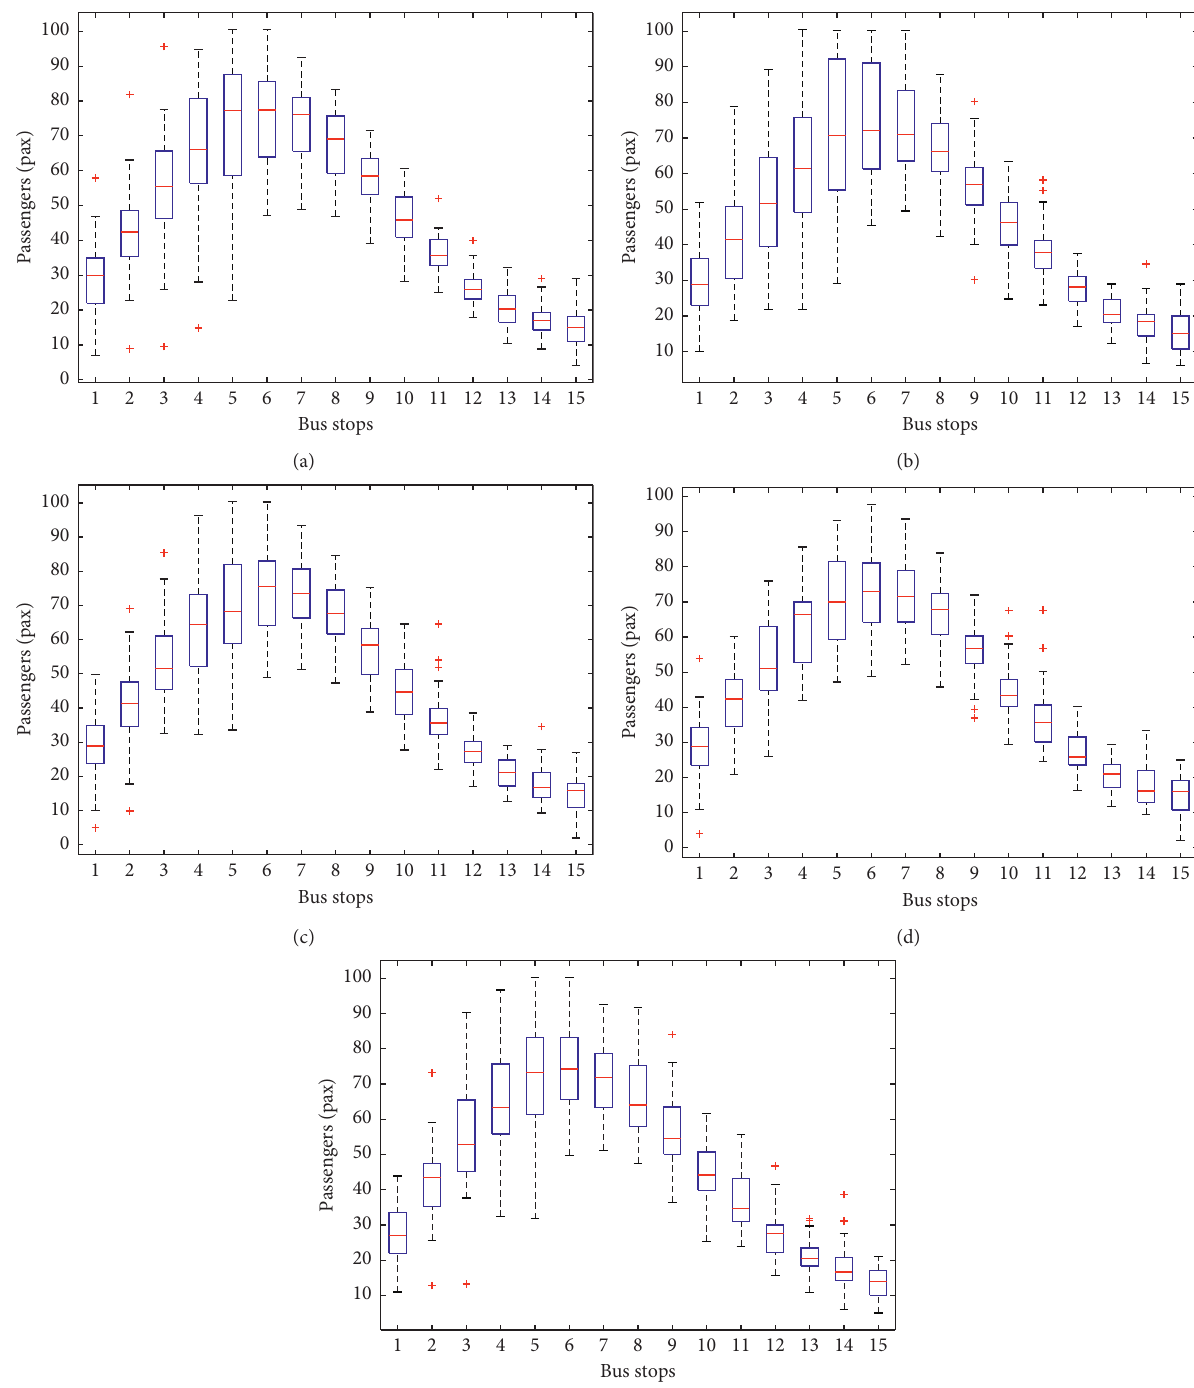
Figure 7: The passengers on buses under different number of CPS. (a) S1. (b) S3. (c) S4. (d) S7. (e)